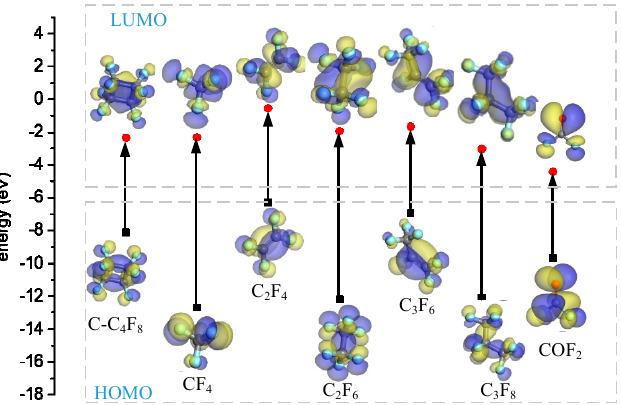
Figure 14. Molecular orbital gap values of decomposition products. Table 6. Parameters of decomposition